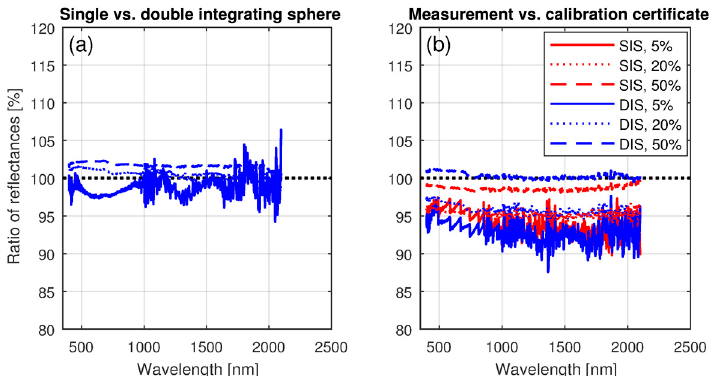
Figure 5. Ratios of mean reflectance spectra of gray-level standards (nominal reflectance values of 5%, 20%, and 50%) measured with different methods. ( a ) Ratio of double integrating sphere (DIS) to single integrating sphere (SIS); ( b ) Ratios of double and single integrating spheres to spectra given in the calibration certificates of the standards. Table 4. Mean absolute difference (mean relative difference in parenthesis) of spectra measured with different methods at visible (VIS), near-infrared (NIR), shortwave-infrared (SWIR), and all wavelengths.